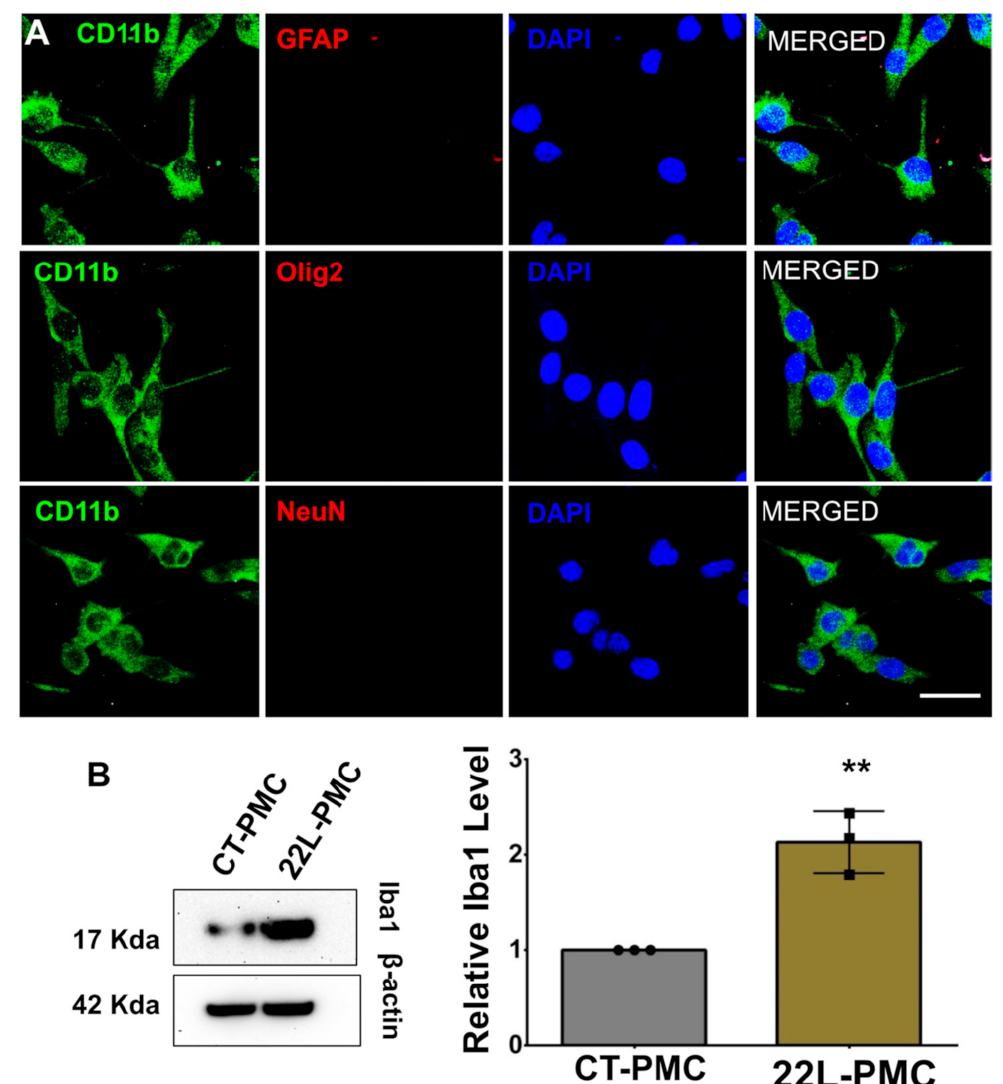
Figure 1. Preparation of adult primary microglia cell cultures. ( A ) Co-immunostaining of PMCs for microglia (CD11b, green) and astrocytes (GFAP, red), oligodendrocytes (Olig2, red), or neurons (NeuN, red). Cell nuclei are stained with DAPI (blue). Images are representatives of three independent cultures, each from an individual control animal. Scale bars = 25 µ m. ( B ) Representative Western blots (left) and densitometric analysis of Iba1 expression levels (right) in CT-PMCs and 22L-PMCs normalized per expression of β -actin. Data are expressed as mean ± SEM, n = 3 independent cultures isolated from individual animals, ** p < 0.01 (two-tailed, unpaired student